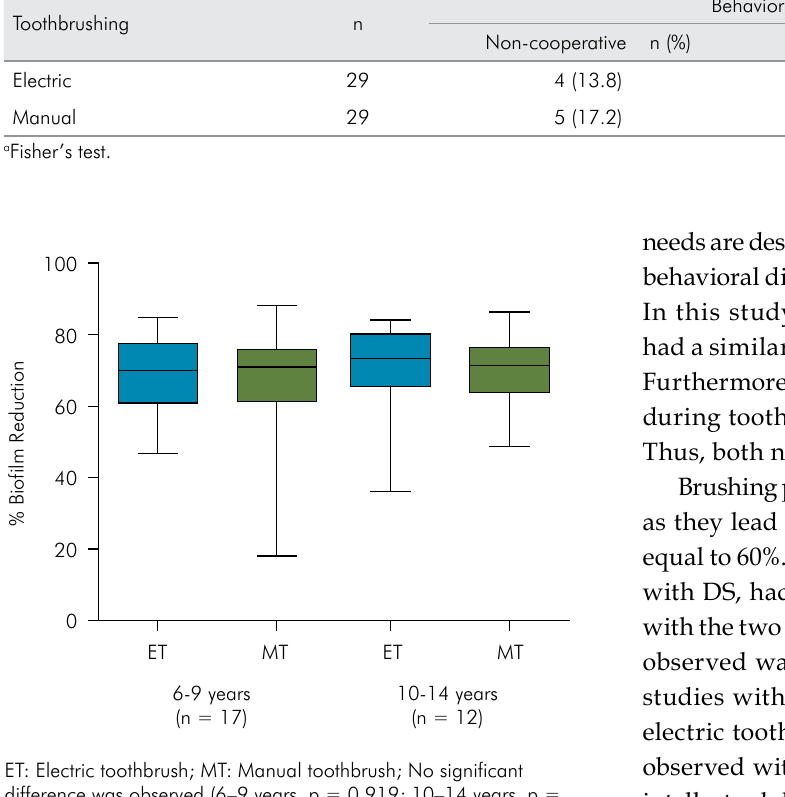
Figure 3. Percent biofilm reduction by age group and toothbrush type.